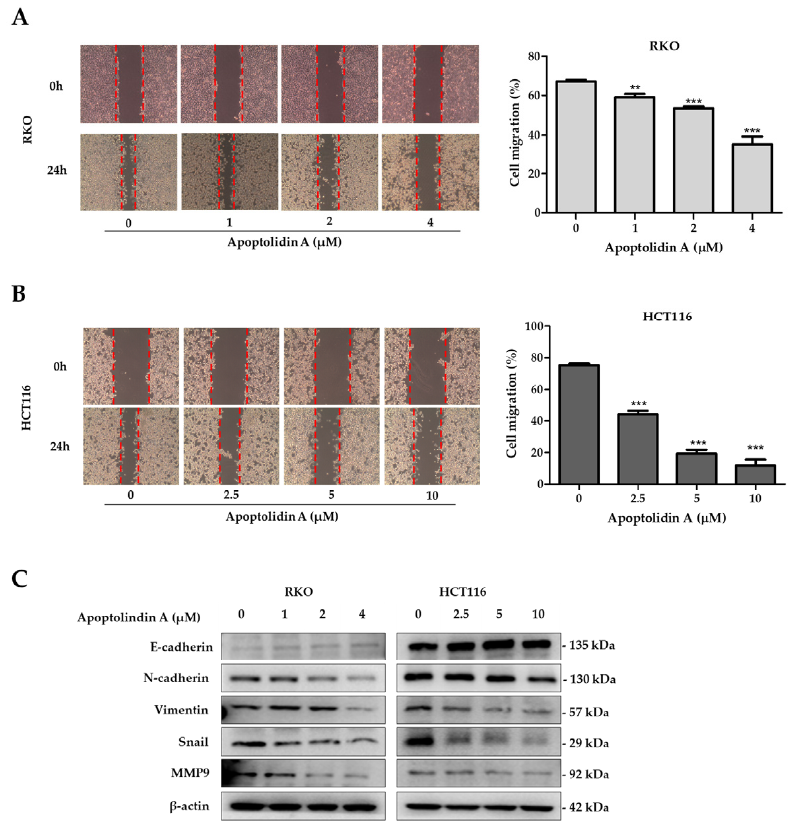
Figure 5. Effect of apoptolidin A on CRC cell migration. Wound healing assay of ( A ) RKO and ( B ) HCT116 cells after treatment with the indicated concentrations of apoptolidin A for 24 h. Images of a typical wound closure captured with a light microscope are displayed (left panel). Measurement of the wound area using Image J (right panel). Data are presented as the mean values ± SD from three independent experiments. ** p < 0.01, and *** p < 0.001 indicate statistically significant differ- ence compared with the vehicle-treated control. ( C ) Immunoblotting was performed to assess the expression of E-cadherin, N-cadherin, vimentin, snail, and MMP9 proteins after 24 h treatment of apoptolidin A. β -Actin was used as an internal control.